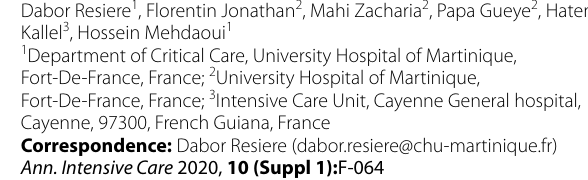
Fig. 1 Kaplan–Meier Curves of Probability of Liver Dysfunction (LD) free days according to Ketamine exposure in the matched cohort F‑064 Cardiovascular complications following Ciguatera fish